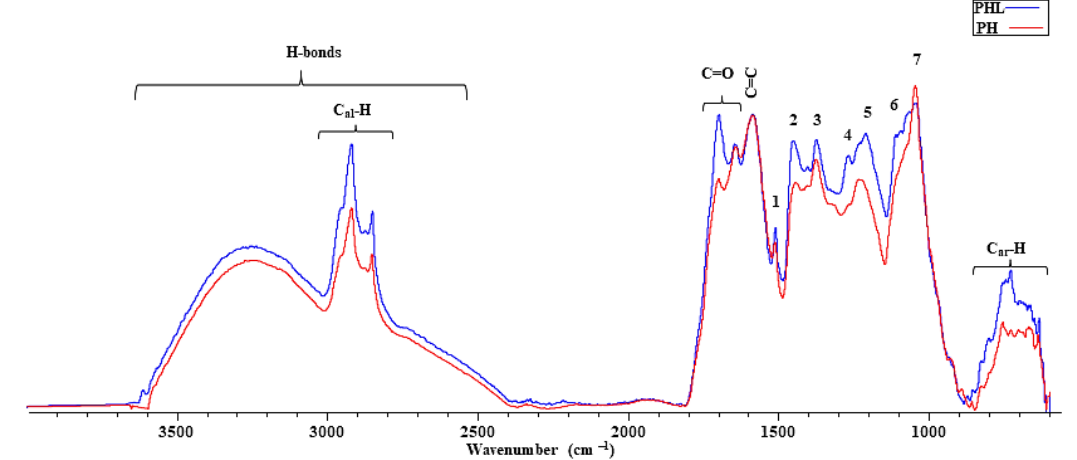
Figure 3. The ATR spectra of condensates from PH samples pyrolysed in loose and densified forms.